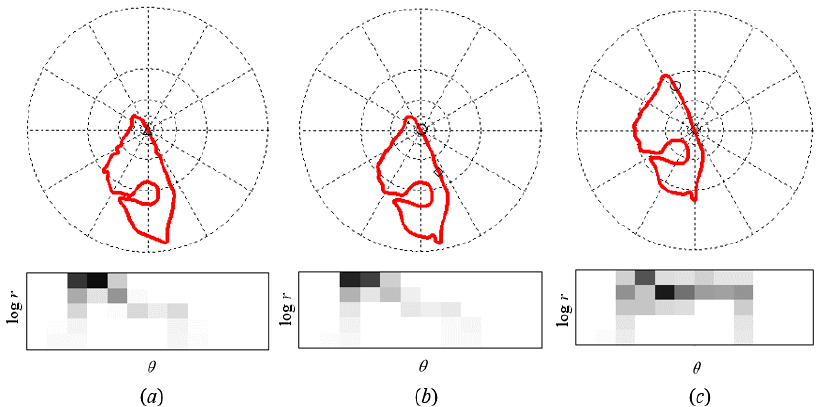
Figure 3. Sampled edge points of two shapes and example histograms of the shape contexts. ( a ) Example shape context for shape A is marked by △ . Example ( b ) and ( c ) shape contexts for shape B are marked by ○ and ◇ . Each shape context is a log-polar histogram of the coordinates of the rest